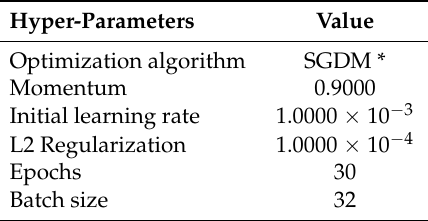
Table 4. Hyper-parameters of the experiments. * Stochastic Gradient Descent with Momentum (SGDM).